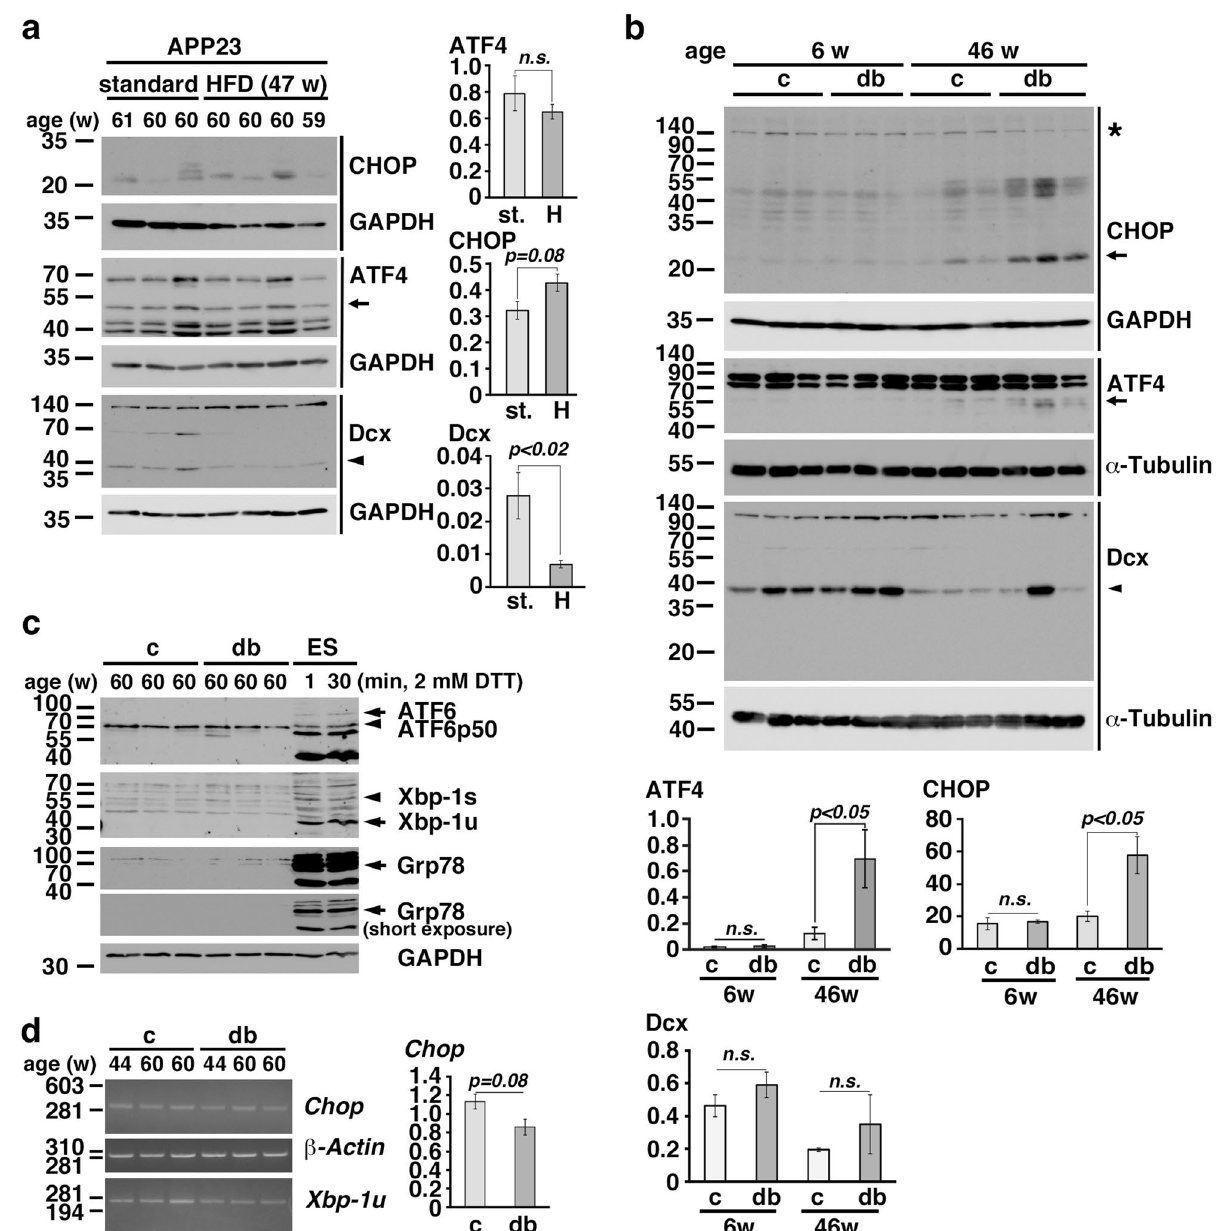
Figure 2. The ER stress was activated in the brains of mice with long-term obesity. ( a , b ) CHOP, ATF4, and Dcx expression in the hippocampi of APP23 mice with long-term HFD-induced obesity ( a ) and db/db mice ( b ). st.: standard diet; H: high-fat diet. The arrow in each panel indicates ATF4 or CHOP, and the arrowhead in each panel indicates Dcx. The asterisk indicates nonspecific signal ( b ). ( c ) ATF6 and Xbp-1 expression in the hippocampi of 60-week-old db/db mice. The arrowheads in each panel indicate the ATF6 fragment or Xbp-1 s. ES: mouse embryonic stem cell line. ES cells were treated with 2 mM DTT for 1 min or 30 min. ( d ) Semiquatitative RT–PCR of Chop in the hippocampi of aged control and db / db mice. (a-c) Statistical significance ( p < 0.05) was determined by Student’s t test. The error bars represent the SEMs. n.s.: not